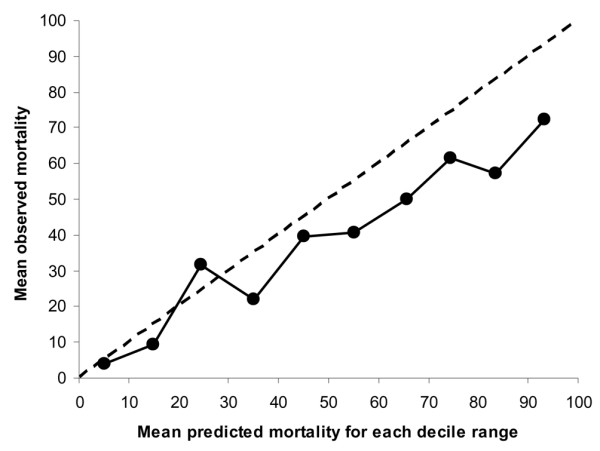
Calibration curve of the UK APACHE II Model at the Royal Berkshire Hospital, 1 January 2003 to 30 June 2004.